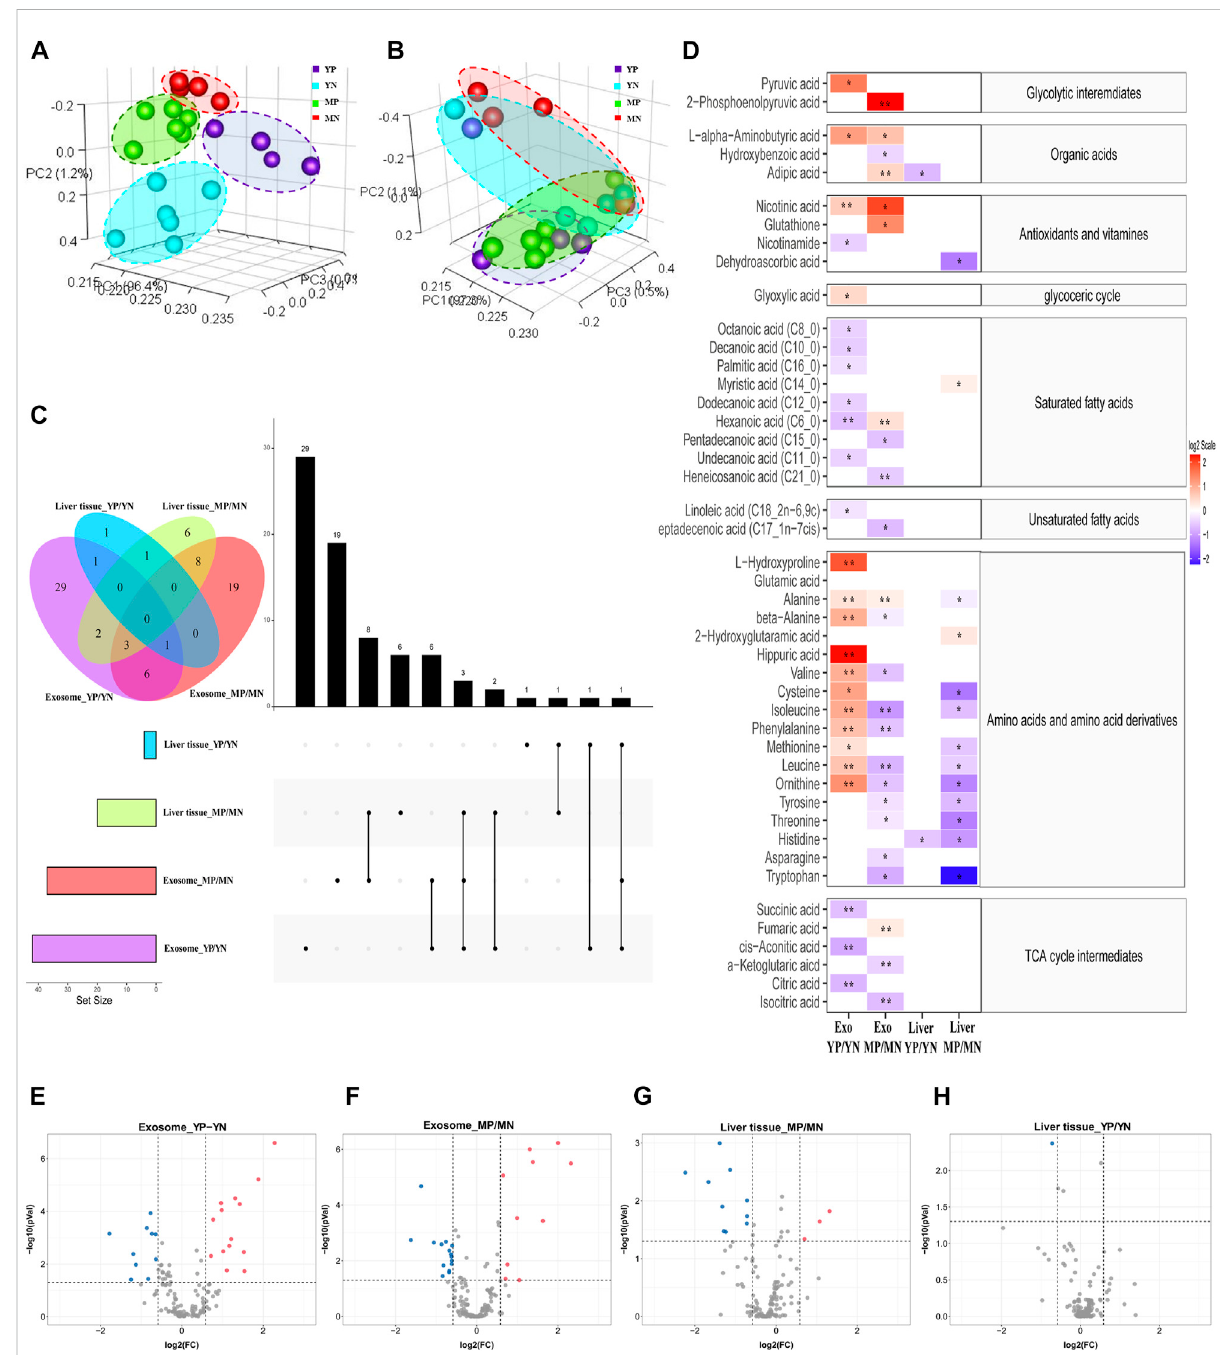
FIGURE 2 Principal component analysis (PCA) of metabolite patterns in (A) exosomes and (B) liver tissues. (C) Upset plot and Venn diagram of differential ( p < 0.05) metabolites. The individual or connected dots represent the various intersections of metabolites that were either unique to or shared among comparisons. (D) Heatmap of the metabolites detected in each group showing the ratio of metabolites levels among the groups. Red color represents higher metabolites concentrations in PCOS groups than the normal groups, while blue color indicates lower levels in PCOS groups than the normal groups. The relative concentration of metabolites was plotted using a log2 scale, the signi fi cant fatty acids with p-values less than 0.05 are labelled with single asterisk, and q-values less than 0.05 are labelled with double asterisk. (E – H) Volcano plot of the differential ( p < 0.05, FC > 1.5) metabolites in different positions. Red dots indicated upregulation, and blue dots indicated